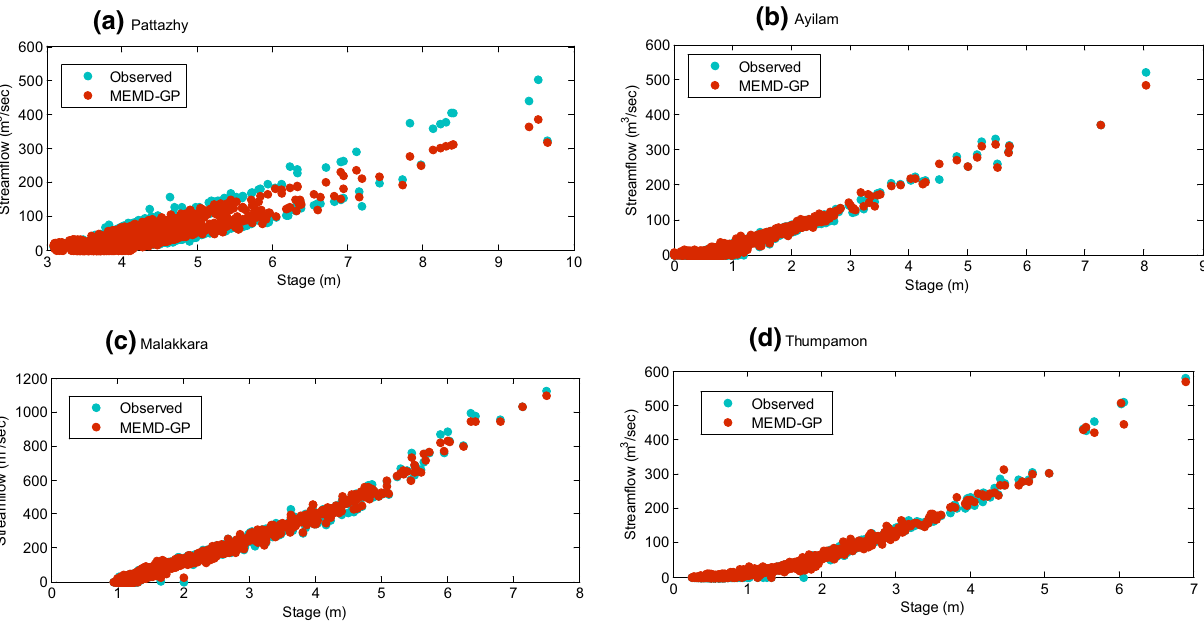
Fig. 8 Stage–discharge relationships developed for the four stations a Pattazhy; b Ayilam; c Malakkara; d Thumpamon using MEMD–GP hybrid